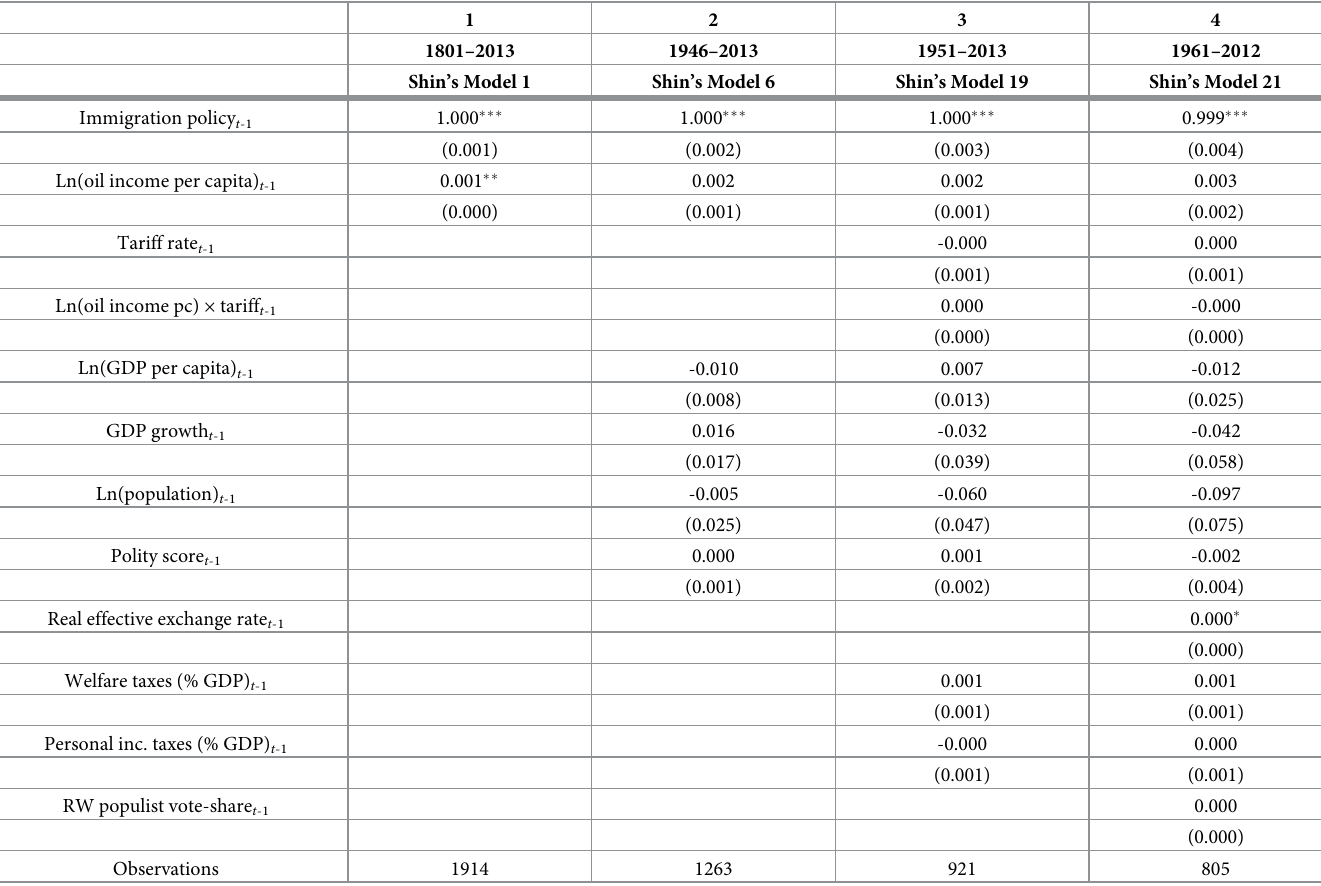
Table 4. Oil wealth and immigration policy: Robust